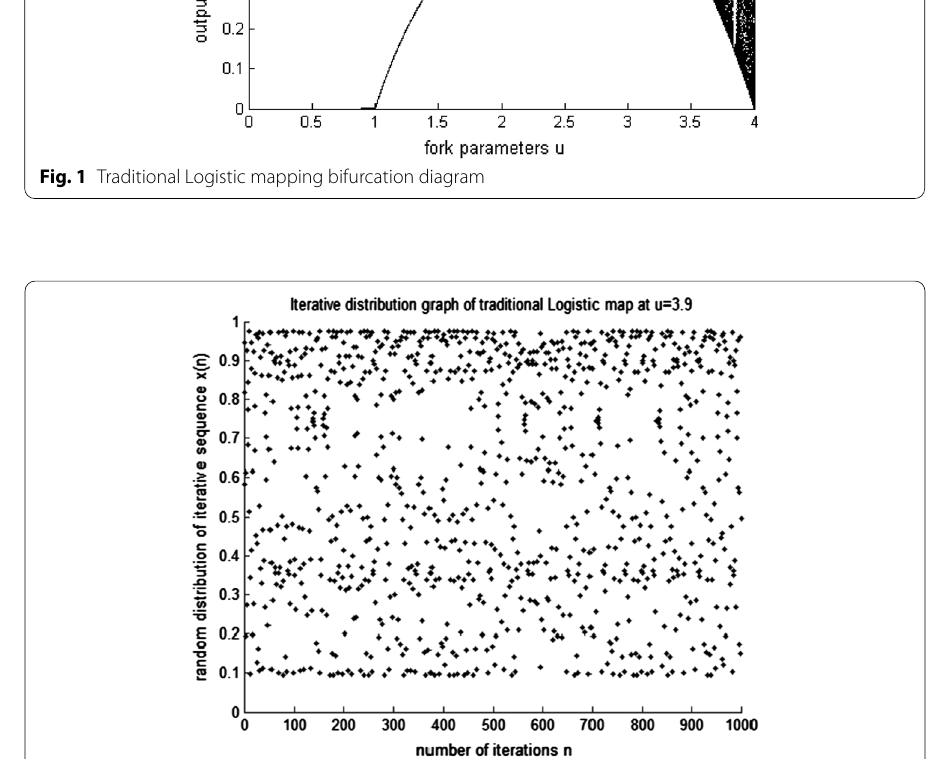
Fig. 2 Iterative distribution graph with the control parameter